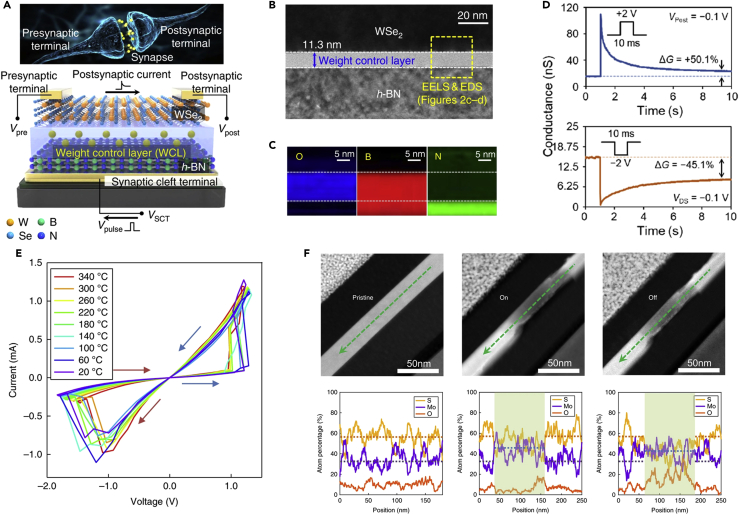
vdW heterostructures with 2D materials for neuromorphic applications(A) Schematic illustration of an h-BN/WCL/WSe2 synaptic device.(B and C) (B) Cross-sectional TEM image of the h-BN/WCL/WSe2 structure, and (C) electron energy loss spectroscopy mapping images of oxygen, boron, and nitrogen showing the heterostructure corresponding to the yellow box in (B).(D) Conductance trajectories of the excitatory postsynaptic current and inhibitory postsynaptic current when applying pulses with 10 ms width and 2 V amplitude to the WCT. Reprinted with permission from (Seo et al., 2018). Copyright 2018 Springer Nature.(E) Switching performance of a GMG device at different temperatures. The arrows indicate the switching direction.(F) In situ cross-sectional STEM images and corresponding EDS line profiles of a single GMG device in the pristine (left), ON state (center), and OFF state (right). EDS line profiles obtained from the region of green arrows in STEM images. Reprinted with permission from (Wang et al., 2018). Copyright 2018 Springer Nature.